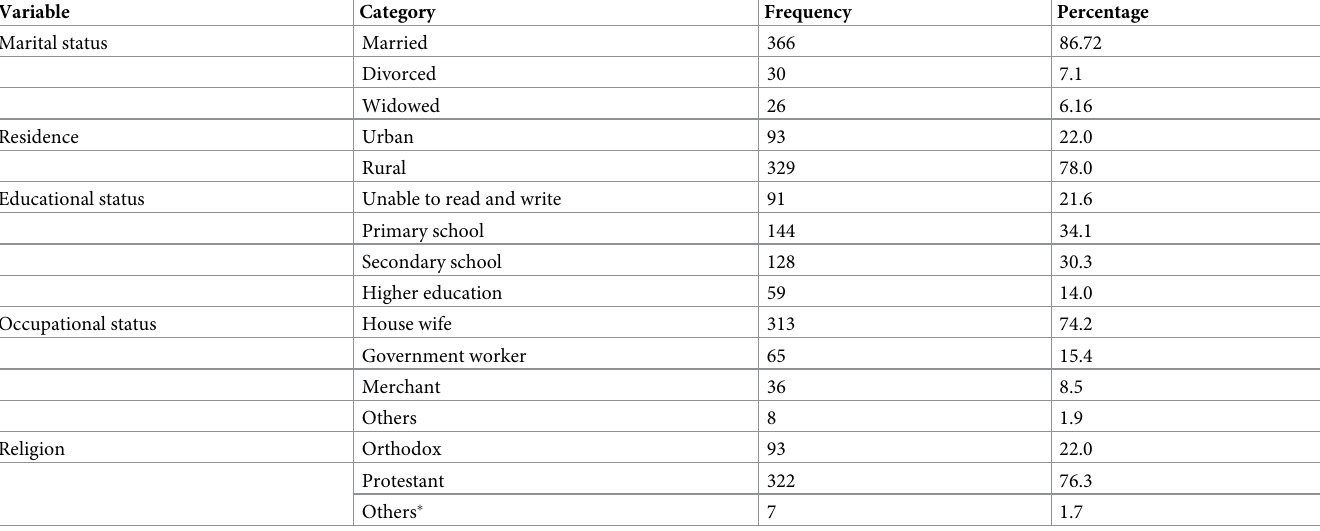
Table 2. Socio-demographic characteristics of study participants in the Loma Woreda, Dawuro Zone, Ethiopia 2020 (n = 422).